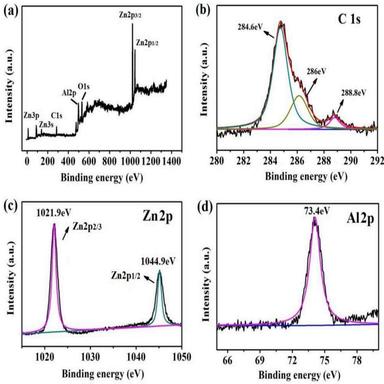
(a) Survey XPS spectrum of the ZnO@C-ZnAl LDHs(15%) sample; (b) C 1s high-resolution spectrum, (c) Zn 2p high-resolution spectrum, and (d) Al 2p high-resolution spectrum of the ZnO@C-ZnAl LDHs(15%) sample (the fitted curves are marked with color lines). (For interpretation of the references to color in this figure legend, the reader is referred to the Web version of this article.)